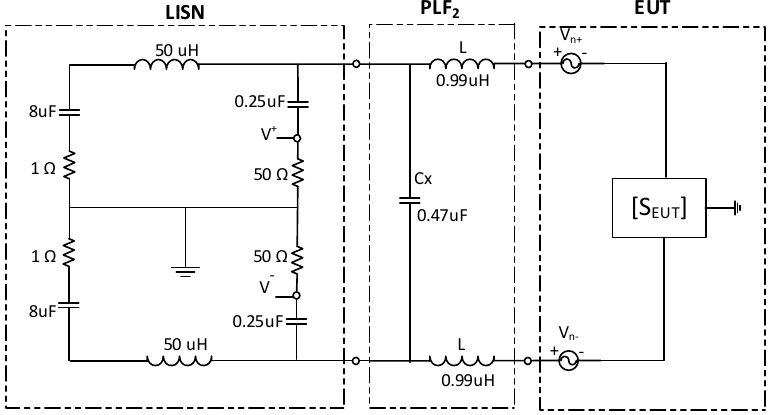
Figure 17. PLF connected between the EUT and the LISN consisting of an X-type capacitor and a DM inductor.